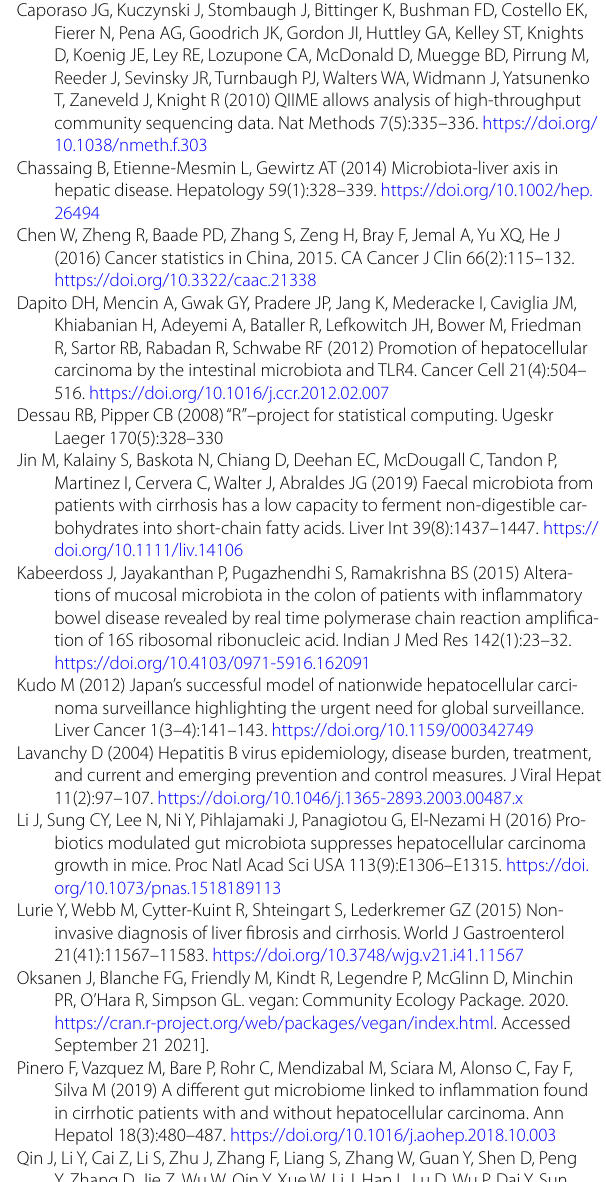
Additional file 1: Figure S1. PCoA of samples from five datasets based on Bray-Curtis distance. PCoA analysis of samples from five datasets based on Bray–Curtis distance showed the fecal microbiota composition was different among studies (p < 0.01) and stages (p < 0.01). Datasets were color-coded and stages (HC, CHB, LC and CRC) were indicated by different shapes. Figure S2. The significantly differential microbe in the development of HCC. (a) Bubble plots of the significantly differential phyla of CHB vs HC, LC vs CHB and HCC vs LC across datasets. (b-d) UpSet plot and bubble plot of the significantly differential genera of CHB vs HC, LC vs CHB and HCC vs LC across datasets. Red and blue represented the direction of differential microbe, the shape size represented the significant level. Figure S3. ROC curve of the RF model based on 14 LC-associated genera combined with age, AST and AFP. (a-c) 14 LC-associated genera combined with age, AST and AFP, respectively. (d) 14 LC-associated genera combined with age and AST. (e) 14 LC-associated genera combined with age and AFP. (f) 14 LC-associated genera combined with AST and AFP. Figure S4. ROC curve of the RF model based on 10 HCC-associated genera combined with age, AST and AFP. (a-c) 10 HCC-associated genera com- bined with age, AST and AFP, respectively. (d) 10 HCC-associated genera combined with age and AST. (e) 10 HCC-associated combined with age and AFP. (f) 14 genera combined with AST and AFP. Table S1. The clinical indicators of Fuzhou samples. Table S2. Statistical analysis of clinical